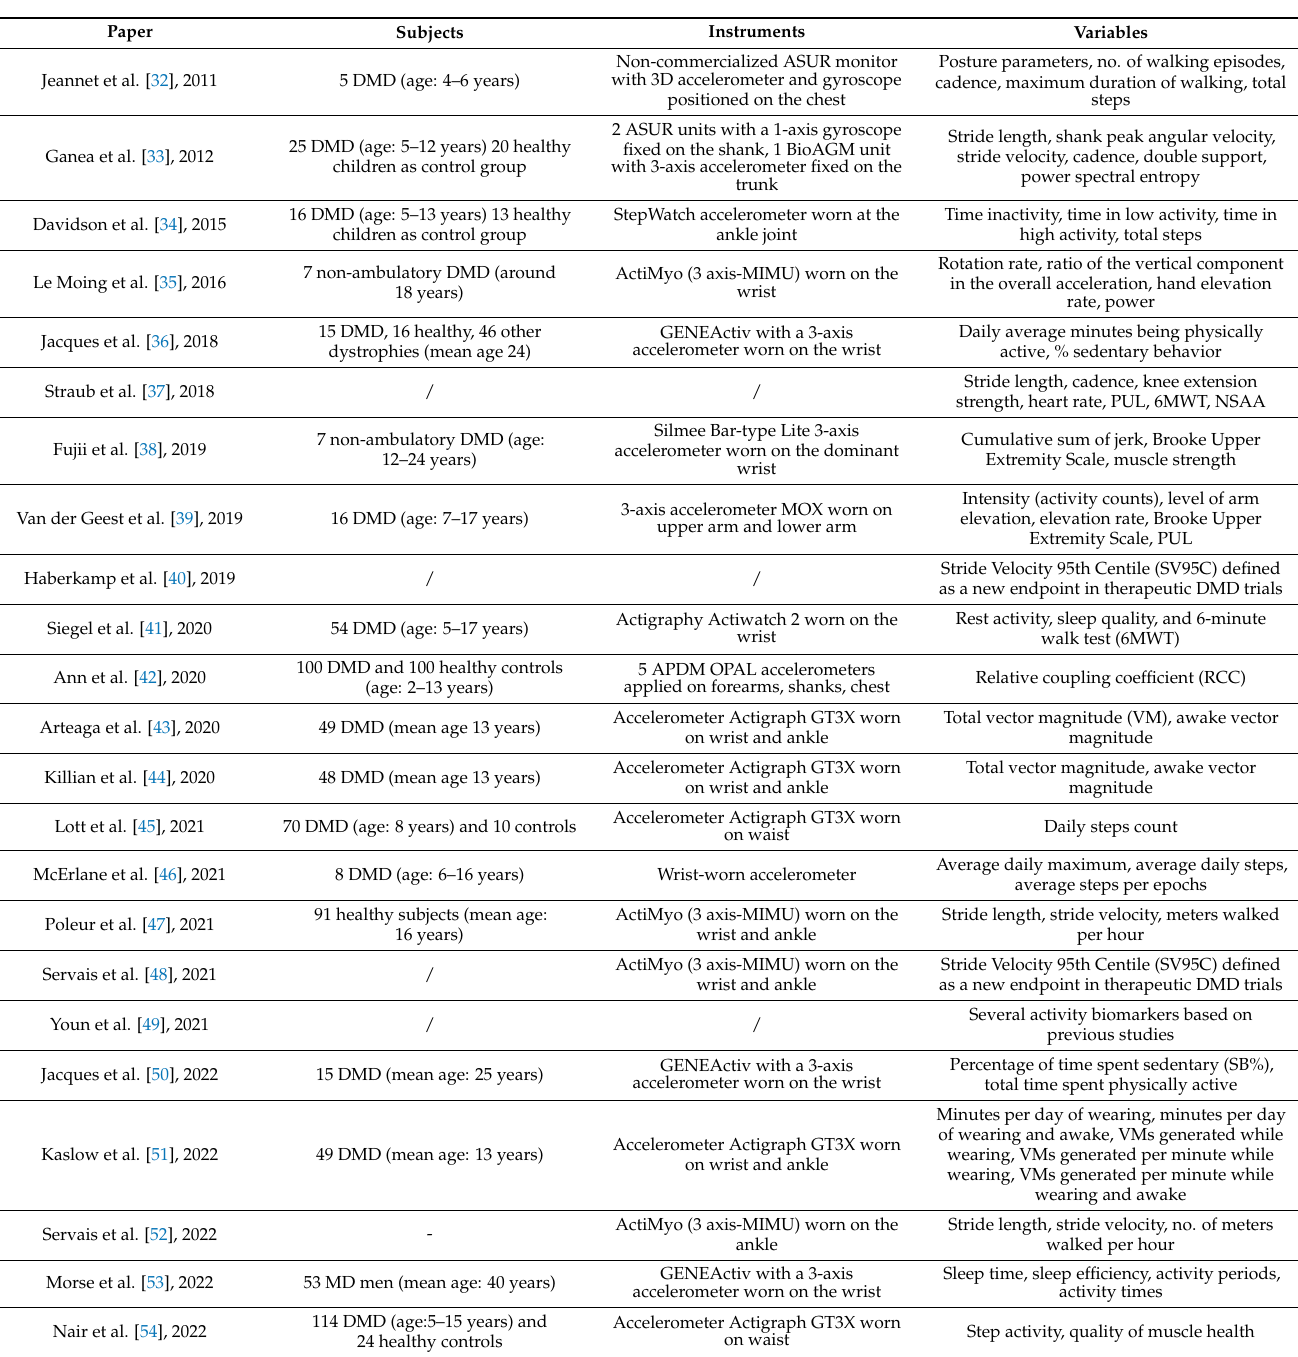
Table 1. Summary of selected